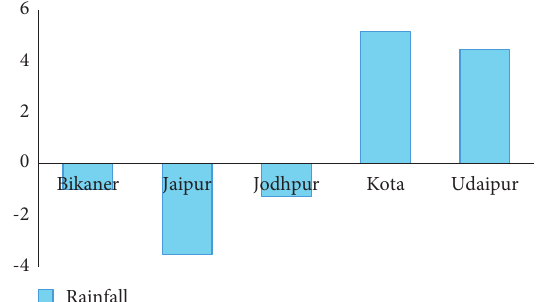
Figure 4: Sen’s slope for rainfall at different